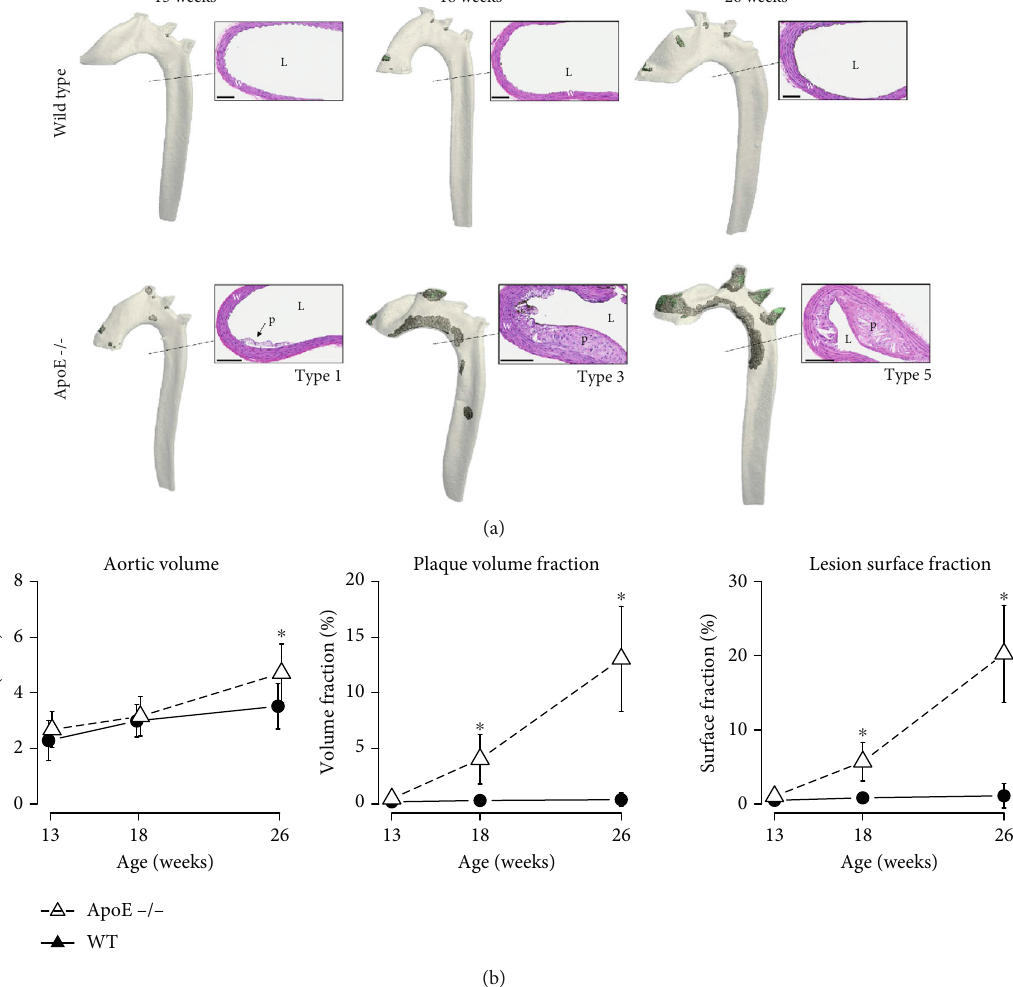
Figure 3: Development of aortic atherosclerosis in ApoE -/- and WT mice. (a) Three-dimensional renderings and corresponding histological (hematoxylin-eosin) sections showing plaque detection at 13, 18, and 26 weeks of age. Bars = 100 μ m, and the cut plane is shown with dotted lines (p: plaque; L: lumen; w: wall). Animals with median plaque volume are shown. WT mice presented no atherosclerotic lesions, while ApoE -/- mice showed progressively larger plaques in the aortic root, lesser curvature of the aortic arch, and principal branches of the aorta over time. (b) Quantitative evolution of aortic volume, plaque volume fraction, and lesion surface fraction in ApoE -/- (triangles/dashed lines) and WT (dots/plain lines) mice. Aortic volumes are comparable between the two groups, but ApoE -/- mice show signi fi cantly larger plaques and lesions. ∗ p < : 05